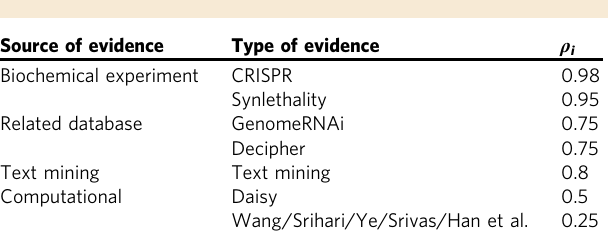
Table 1 Quantitative score of